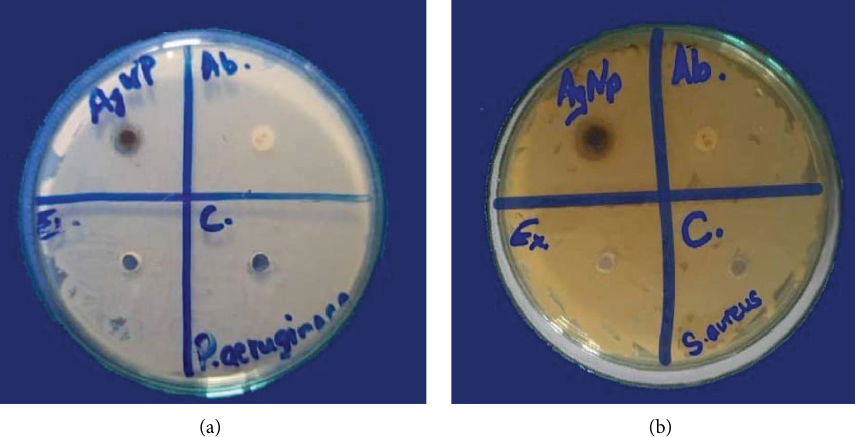
Figure 14: Te antibacterial activity assay of biosynthesized AgNPs against (a) P. aeruginosa and (b) S. aureus . AgNPs showed antibacterial activity against both bacteria. Here, AgNPs, Ab, Ex, and C stand for silver nanoparticles, antibiotic, Aloe vera extract, and control, respectively.